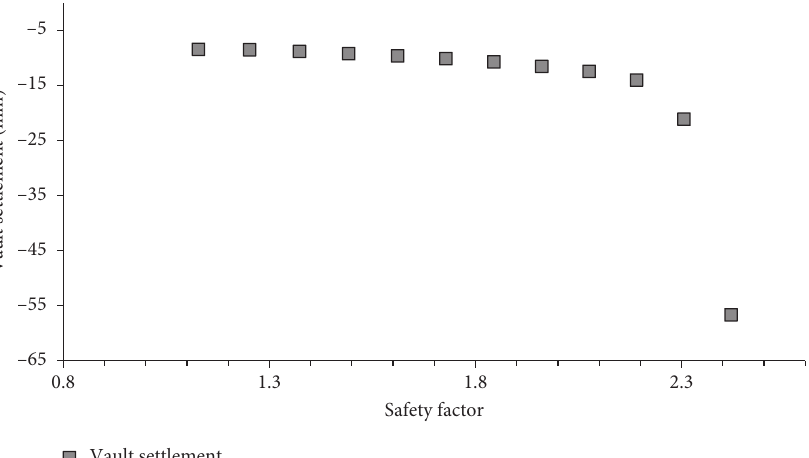
Figure 12: Reduction ratio equal to 0.1 in the